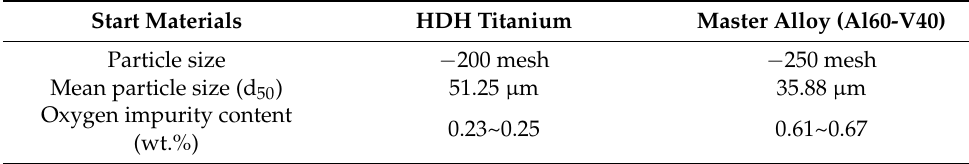
Table 1. Particle size and oxygen impurity content of starting